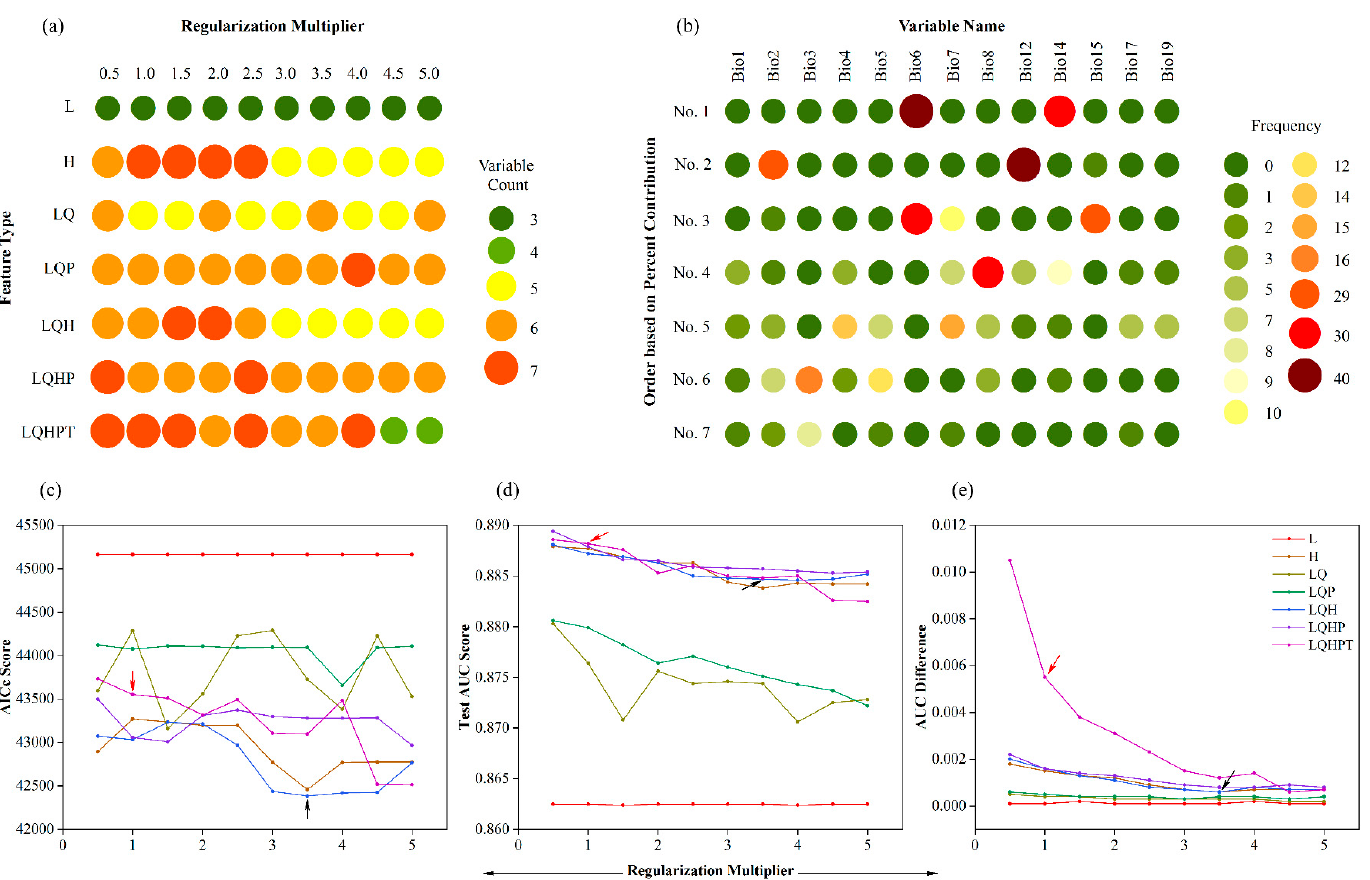
Figure 3. The results of variable selection and three evaluation metrics of the Maxent models run using different combinations of regularization multiplier and feature type. ( a ) Selected variable count of the models. ( b ) Frequency of selected variables with ordering based on percent contribution. ( c ) Sample-size-adjusted Akaike information criterion (AICc) score. ( d ) Test area under the curve (AUC) score. ( e ) Difference between training AUC and test AUC (AUC train - AUC test ) values. Default settings and those that yielded the lowest AICc are indicated with red and black arrows, respectively. Feature classes: L, linear; H, hinge; Q, quadratic; P, product; and T, threshold.